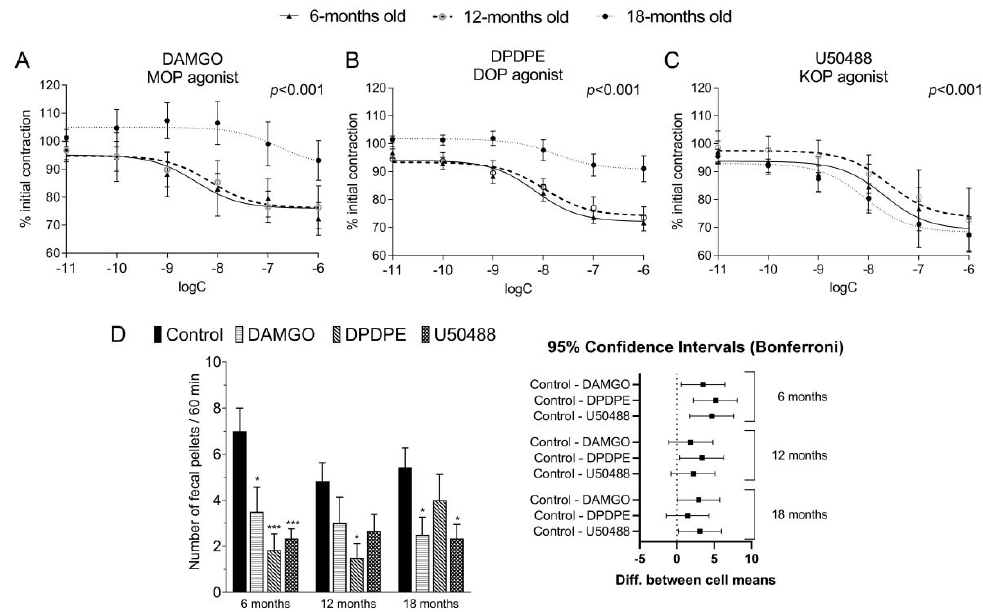
Figure 2. The action of ORs agonists in the GI tract of 6-, 12- and 18-month old mice. Top: dose-dependent effects of ORs agonists: DAMGO (0.1 mg kg − 1 ) ( A ), DPDPE (0.3 mg kg − 1 ), ( B ) and U50488 (1 mg kg − 1 ) ( C ) on EFS-stimulated longitudinal smooth muscles contractility in the colon. Data are presented as mean ± SEM; n = 6–8 where n indicates the number of individual tissues from ≥ 3 different animals. The curves ( A – C ) were fitted to the three-parameter dose-response non-linear regression curve. p value was showed for comparing curves based on the extra-sum-of-squares F test. Bottom ( D ): the effect of DAMGO (0.1 mg kg − 1 ), DPDPE (0.3 mg kg − 1 ), and U50488 (1 mg kg − 1 ) on 60 min fecal pellet output with calculated and graphed 95% Confidence Intervals for the difference of means compared to control (vehicle/placebo) group in right side. The results are expressed as mean ± SEM. One-way analysis of variance (ANOVA) followed by Bonferroni correction test was used to evaluate the difference between groups. * p < 0.05, *** p < 0.001 as compared to matched control.